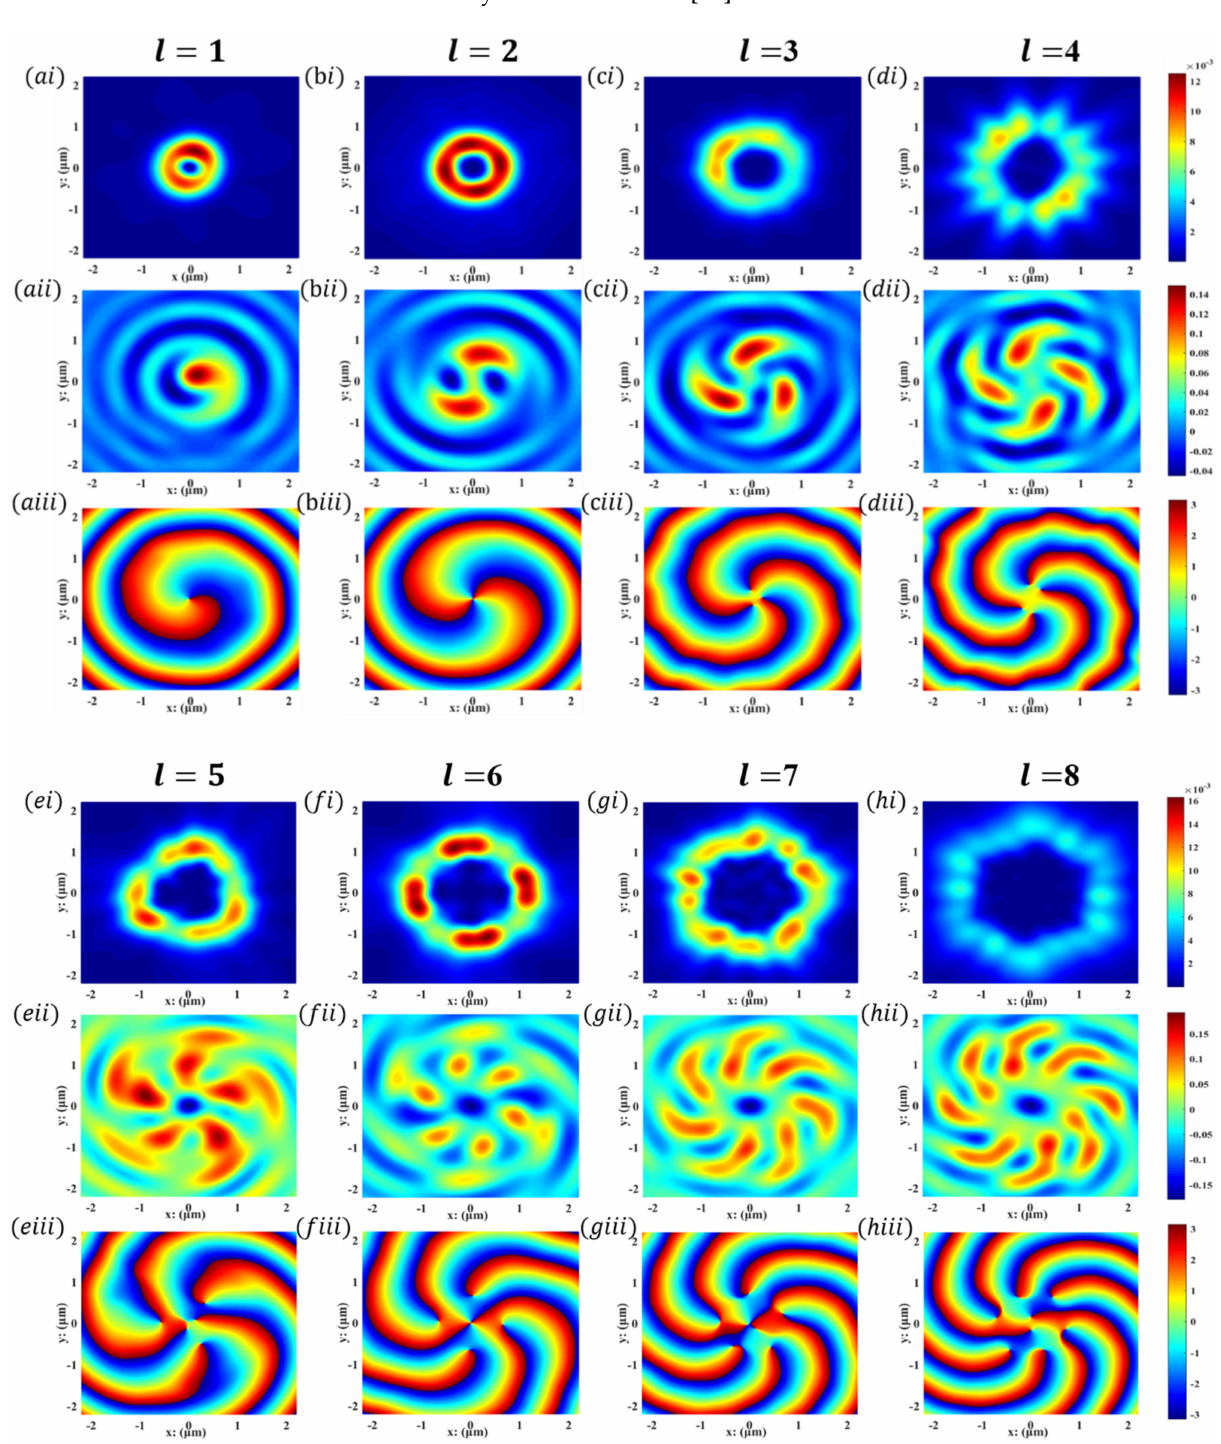
Figure 3. ( a – h ) Generation of OVs with independent first- to eighth-order. ( i ) The focal ring energy distribution of transmitted light, or actually the power of the cross-polarized output field. ( ii ) The distribution of the transmitted electric field E x in the x direction. ( iii ) The phase distribution of the transmitted light. In all simulations in this figure, the incident light is set at 632 nm, and all data are collected at z 1 = 2000